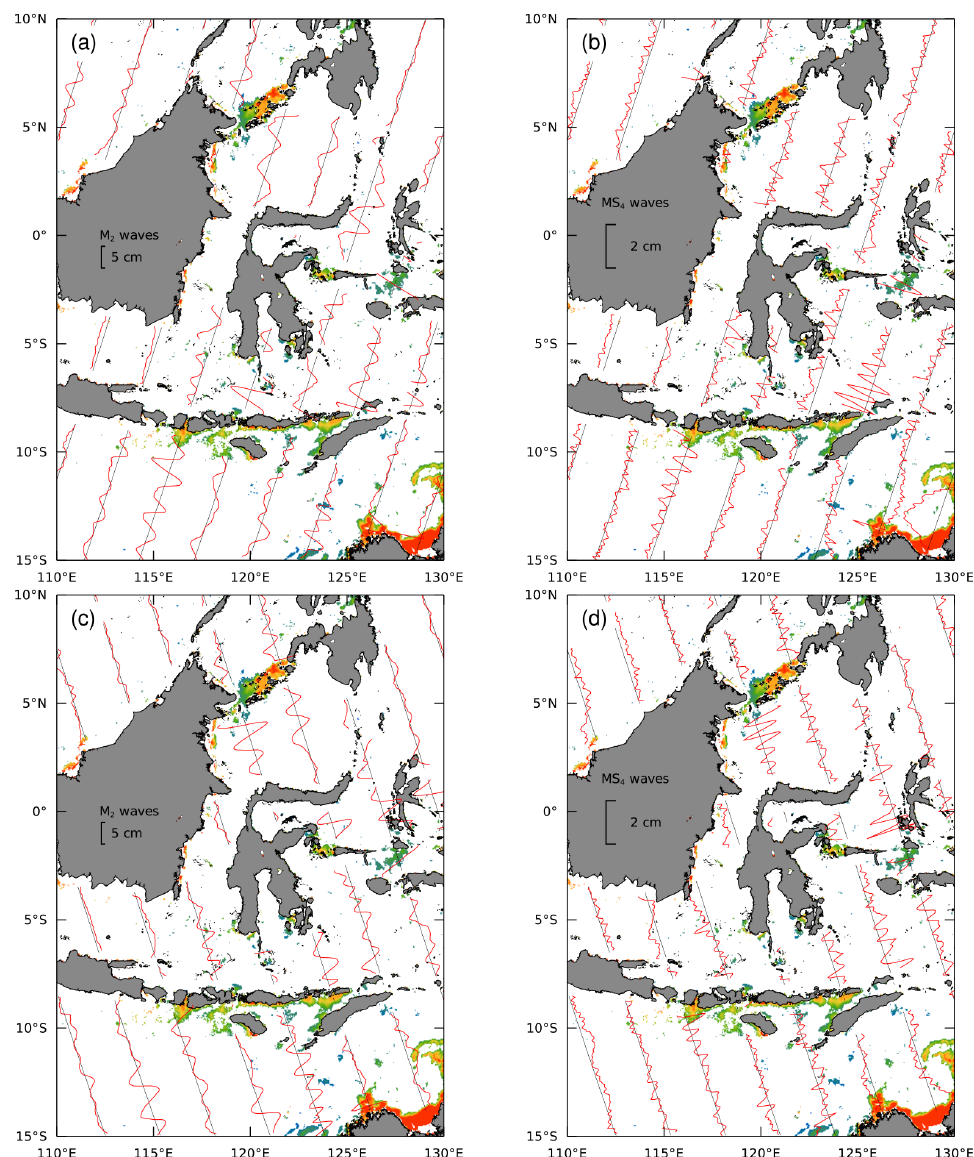
Figure 7. Harmonic analysis of along-track altimeter data. Panels (a) and (c) show sea level anomaly associated with the M 2 astronomical tide. Panels (b) and (d) show sea level anomaly associated with the MS 4 nonlinear overtide. Ascending and descending orbit ground tracks are shown in the upper and lower panels, respectively. The background image is reproduced enlarged from Fig. 3d, with gray values plotted in white for